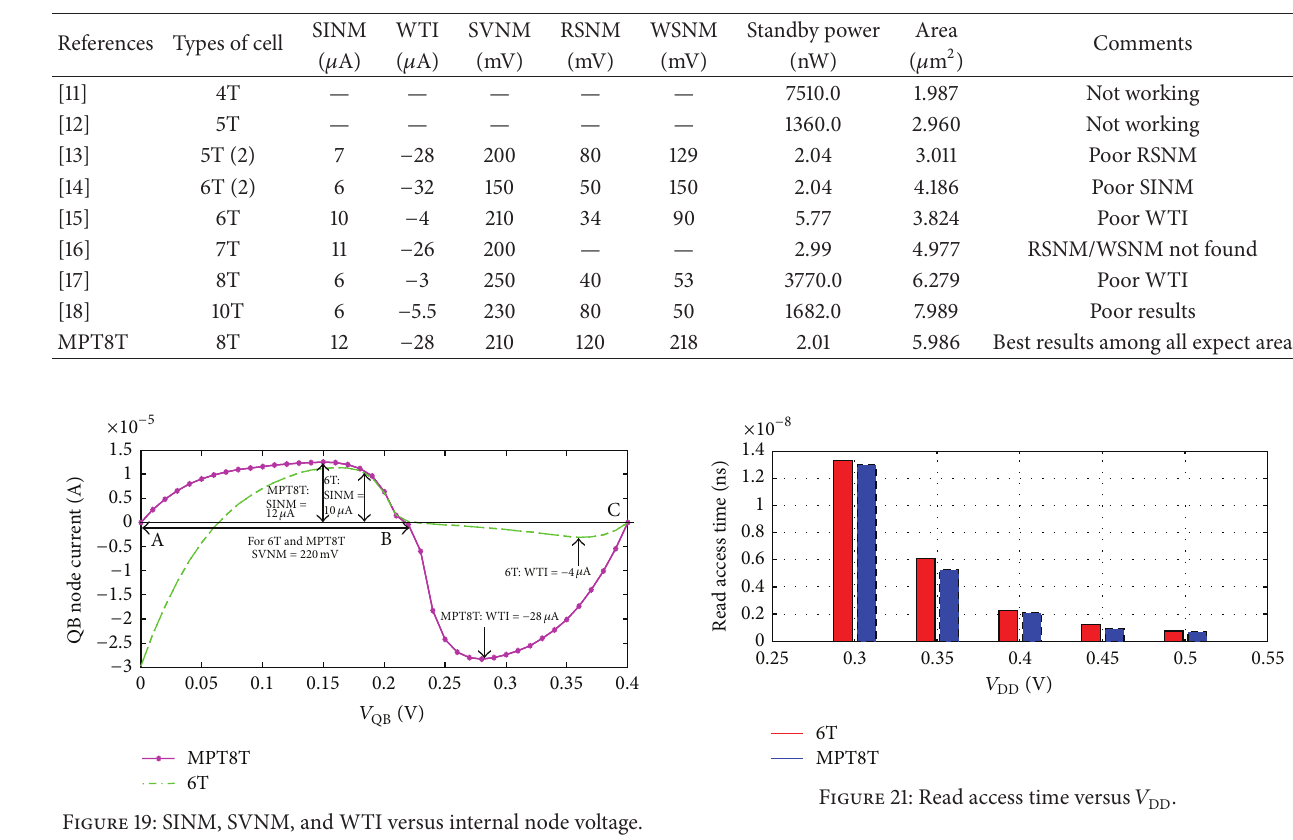
Table 3: Comparison of various SRAM cells at 45 nm technology.